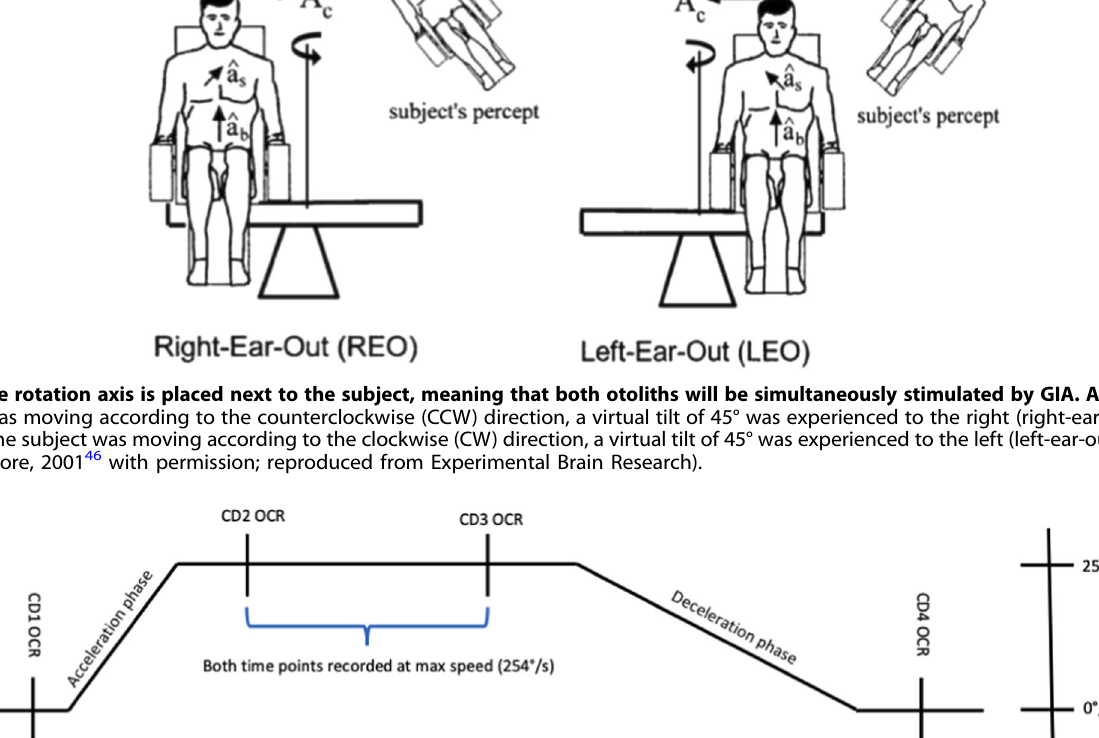
Table 1. Overview OCR values. CCW left, inner, eye CCW right, outer, eye CW left, outer, eye CW right, inner, eye